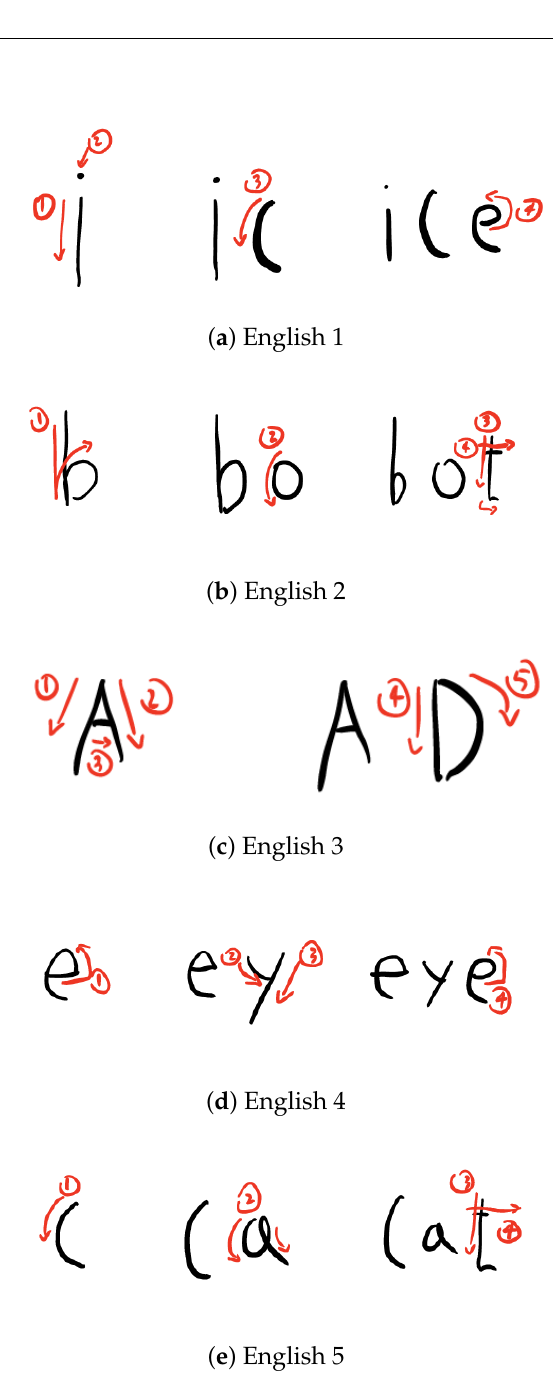
Figure A1. Drawing patterns of the ‘English’ drawing pattern used in this